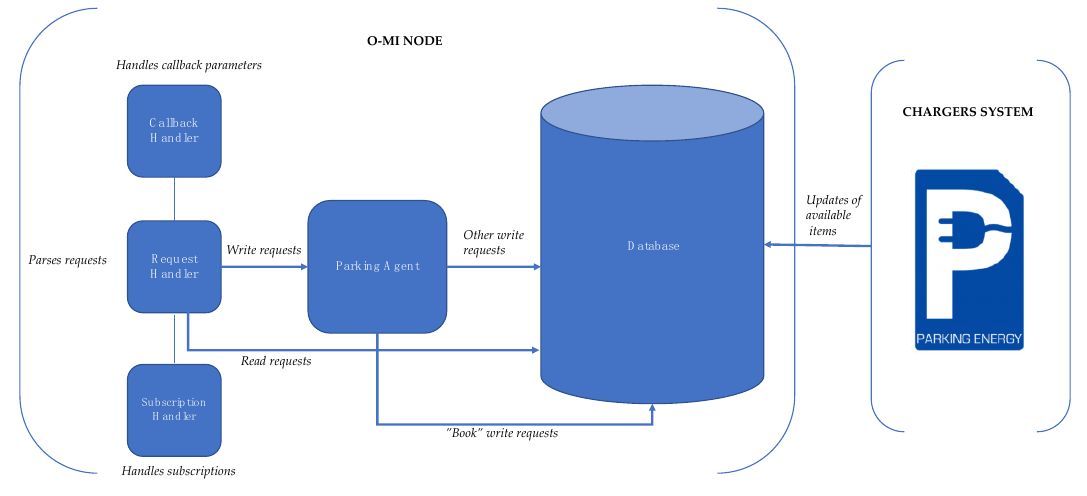
Figure 5. Parking and Charging Service Architecture.